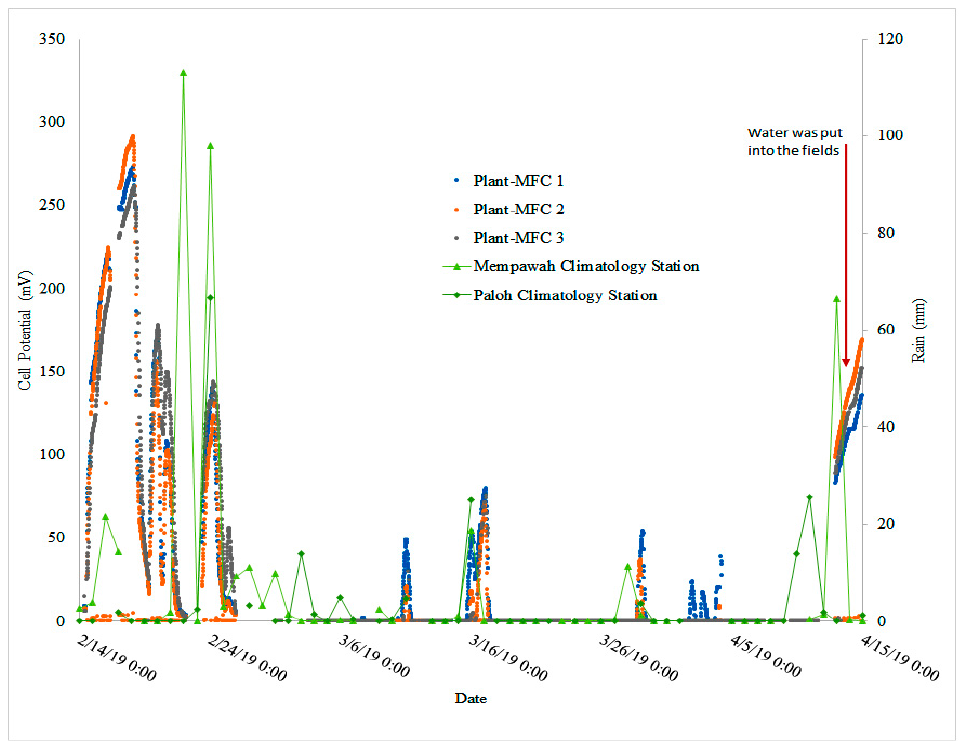
Figure 9. Cell potential peak (possibly) due to rain events. The rain events data were obtained from the two nearest climatology